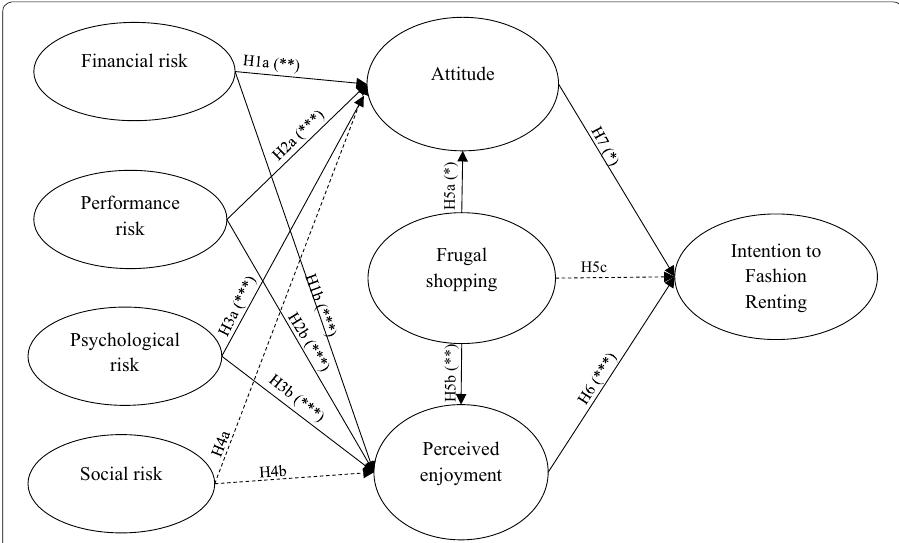
Fig. 1 Analysis results of the determinants of fashion renting.***p < 0.001, **p < 0.01, *p < 0.05; dotted lines indicate non-significant